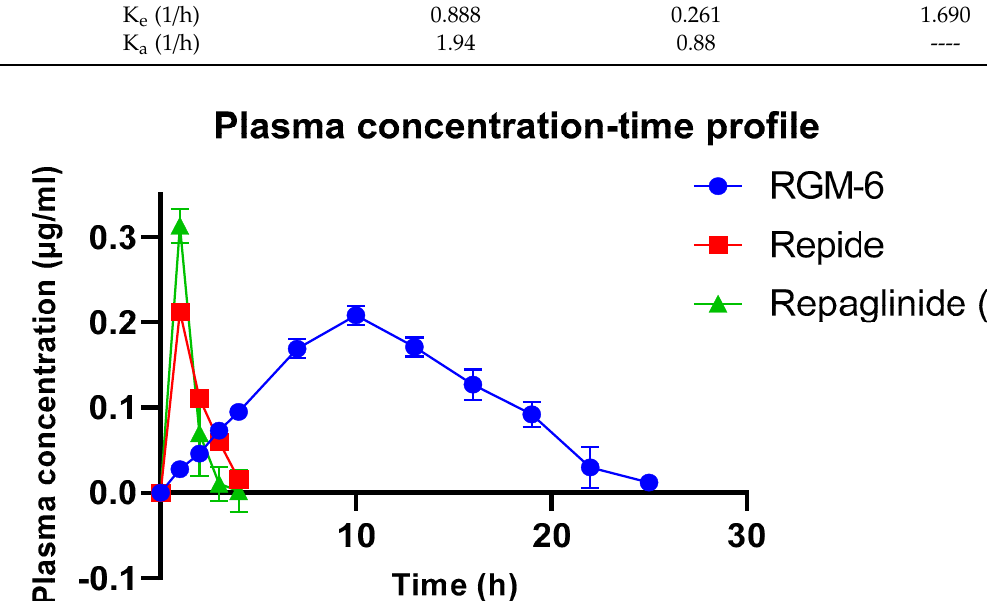
Figure 11. Plasma concentration-time profile for RGM-6 and REPIDE following oral administration (n = 6).